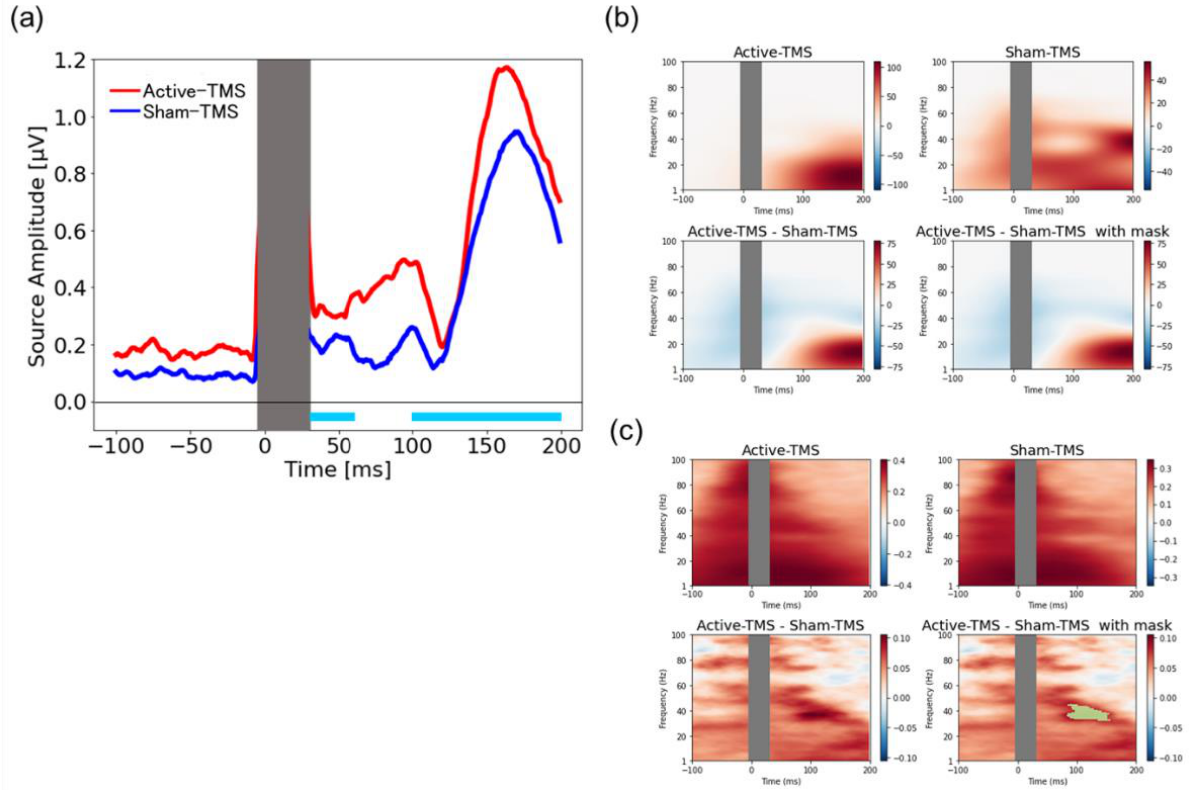
Figure 4. Source-based TMS-elicited response and their time – frequency analyses. ( a ) The upper panel shows the averaged TMS-elicited response for all participants confined to the source-based region, including the DLPFC stimulation site (the rostral middle frontal gyrus) with active and sham conditions (active stimulation is shown as red waveform and sham stimulation is shown as blue waveform). The intervals at which significant differences (30 – 60 ms) were found in permutation t-tests are indicated by the light-blue bars. ( b ) The upper panel shows the total power based on time – frequency analysis with the active condition ( upper left ) and sham condition ( upper right ) in the source-based region, including the DLPFC stimulation site. The lower-left panel shows the differences in total power between the active and sham conditions. A two-dimensional cluster-based permutation test did not detect any significant differences between the two conditions ( lower right ). ( c ) The upper panel shows the ITPC based on time – frequency analysis with active condition ( upper left ) and sham condition ( upper right ) in the source-based region, including the DLPFC stimulation site. The lower-left panel shows the differences in ITPC between the active and sham conditions. The areas showing significant differences between the two conditions in the two-dimensional clus- ter-based permutation test are marked with a green mask ( lower right ). 3.6. Subjective Differences in Stimulus Sensation between Active and Sham Coils The results of the differences in stimulus sensation (i.e., stimulus intensity, spread of the stimulus site, and loudness of the coil click sound) between active and sham stimula- tion coils are as follows: (1) feeling of stimulus intensity (percentage of participants who correctly answered that the sham stimulation was a sham condition: 17.9%; χ 2 (2) = 0.55, p = 0.46); (2) feeling of spread of the stimulus site (same as above: 14.3%; χ 2 (2) = 0.03, p = 0.85); and (3) feeling of loudness of the coil click sound (same as above: 7.1%; χ 2 (2) = 0.87, p = 0.35). Of note is that the results of the questionnaire showed no significant difference between active and sham stimulation with respect to each element of stimulus sensation.